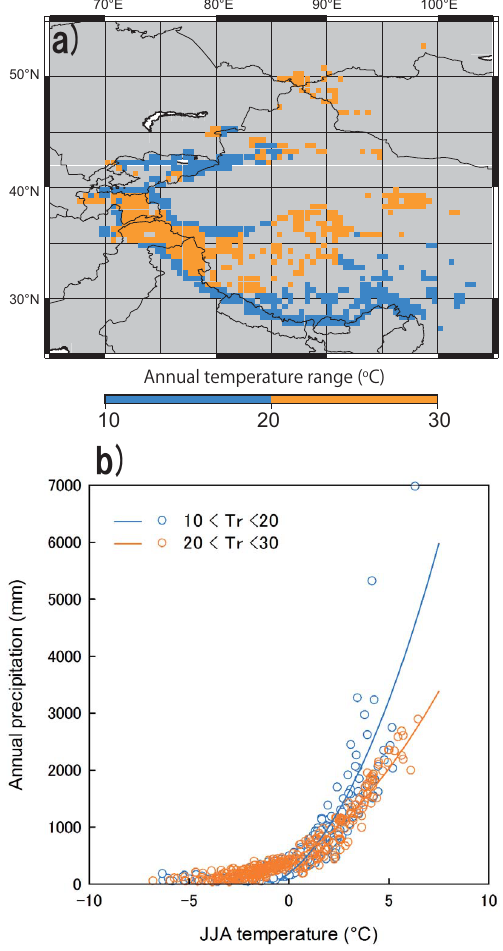
Figure 11. Distribution of annual temperature range (a) and T-P plot of different temperature ranges. Tr indicates annual temperature range (b)